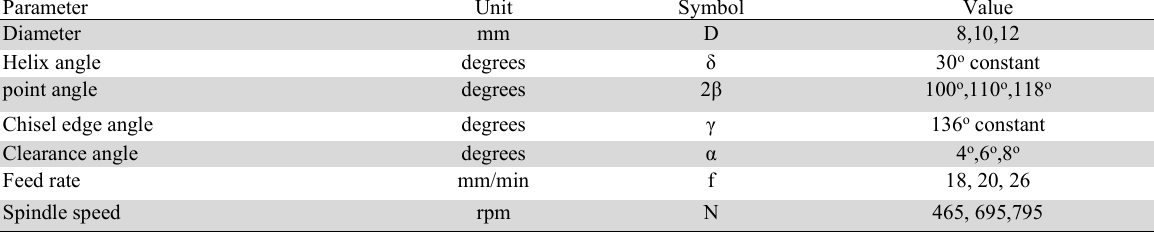
Drill bit geometrical parameters Parameter Unit Symbol Value Diameter